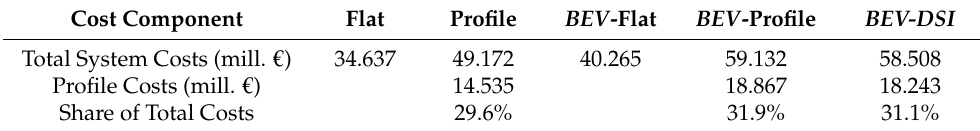
Table 7. Total system costs and determined profile costs for the scenarios with and without BEV . Cost Component Total System Costs (mill. € )